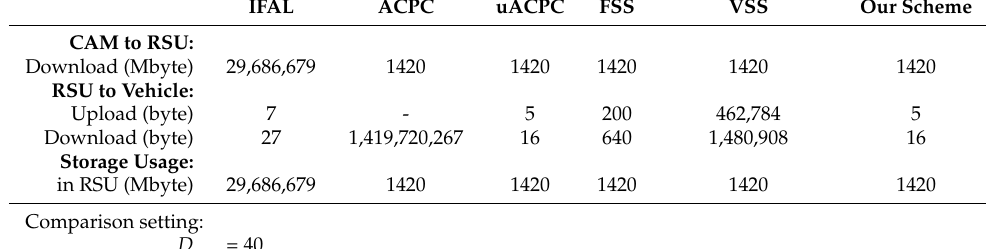
Table 2. Performance cost under example parameters. IFAL ACPC Our